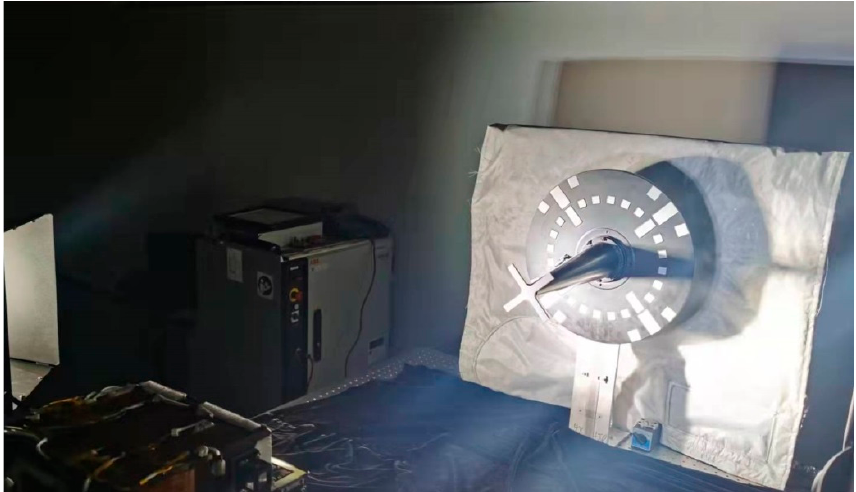
Figure 13. Dataset-generation